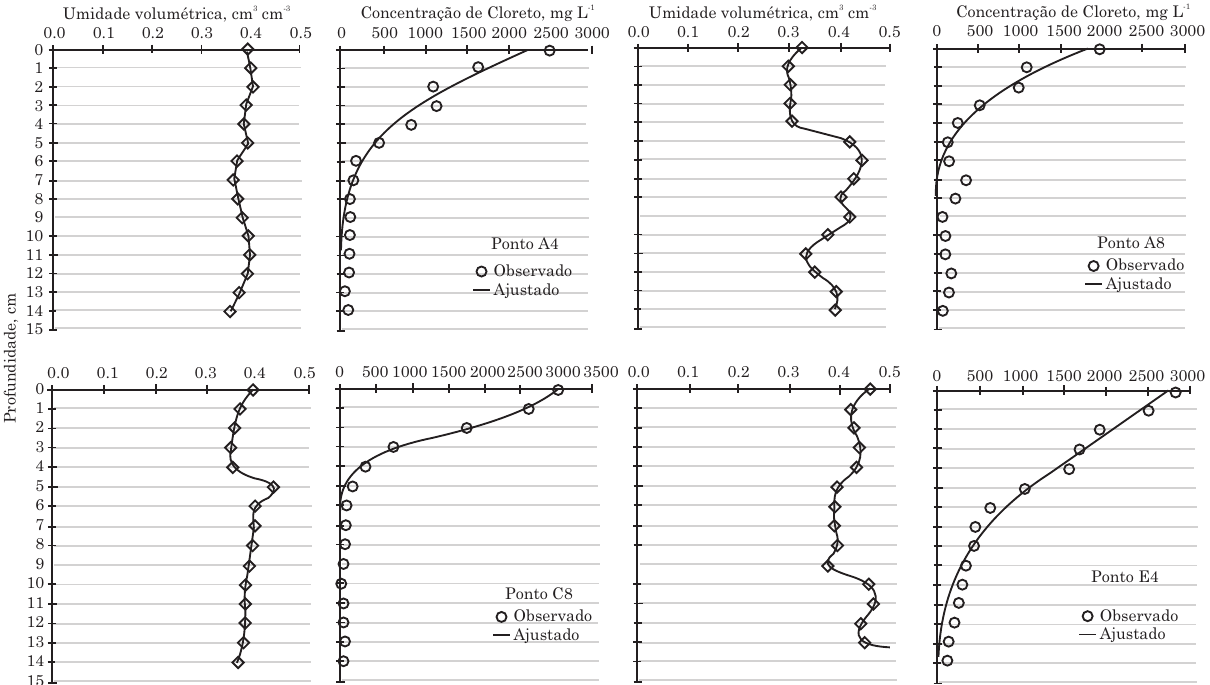
Figura 3. Perfis da umidade volumétrica final e das concentrações de cloreto (experimentais e ajustados pelo modelo CD) para os pontos A4, A8, C8 e